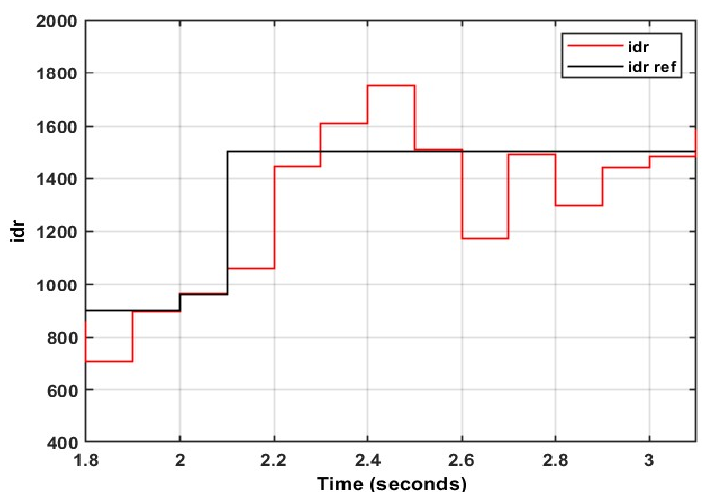
Figure 36. Rotor direct axis current average using PI at 80% dip.